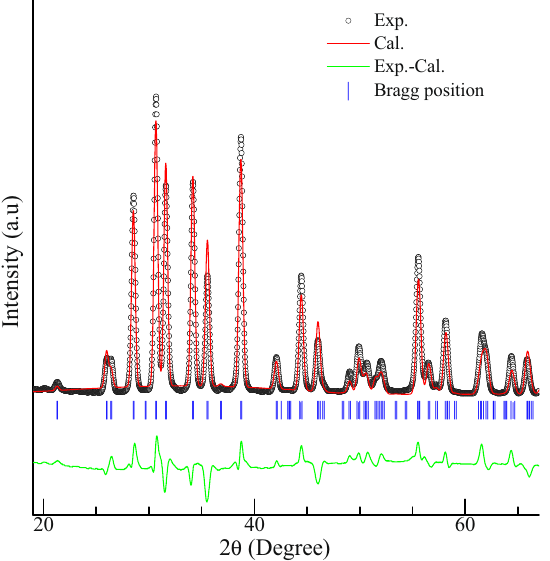
Figure 1. Rietveld refined powder x-ray diffraction pattern of CeGe. The difference between the observed and the experimental pattern and the Bragg position are also